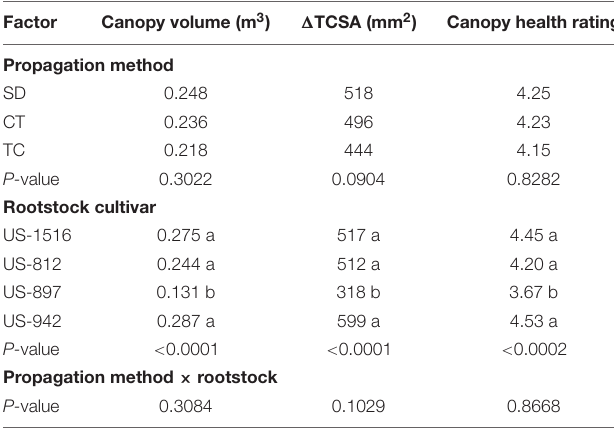
TABLE 2 | Canopy volume, increase in trunk cross sectional area ( (cid:49) TCSA), and canopy health rating of ‘Valencia’ trees on different rootstocks propagated by seed (SD), cuttings (CT), and tissue culture (TC) after 18 months in the